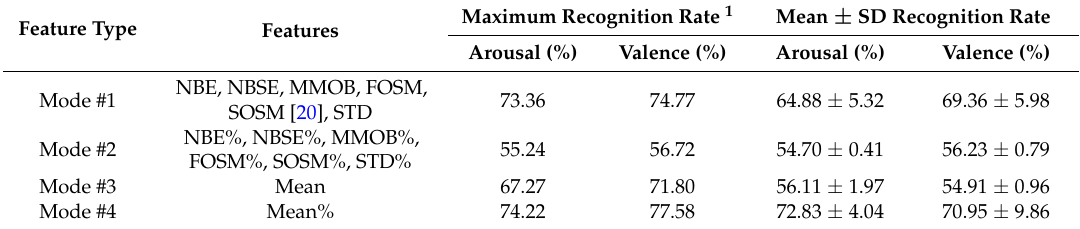
Table 1. Recognition rate comparison of various feature type. MMOB, mean-magnitude of bispectrum; FOSM, first order spectral moment; SOSM, second order spectral moment; STD, standard